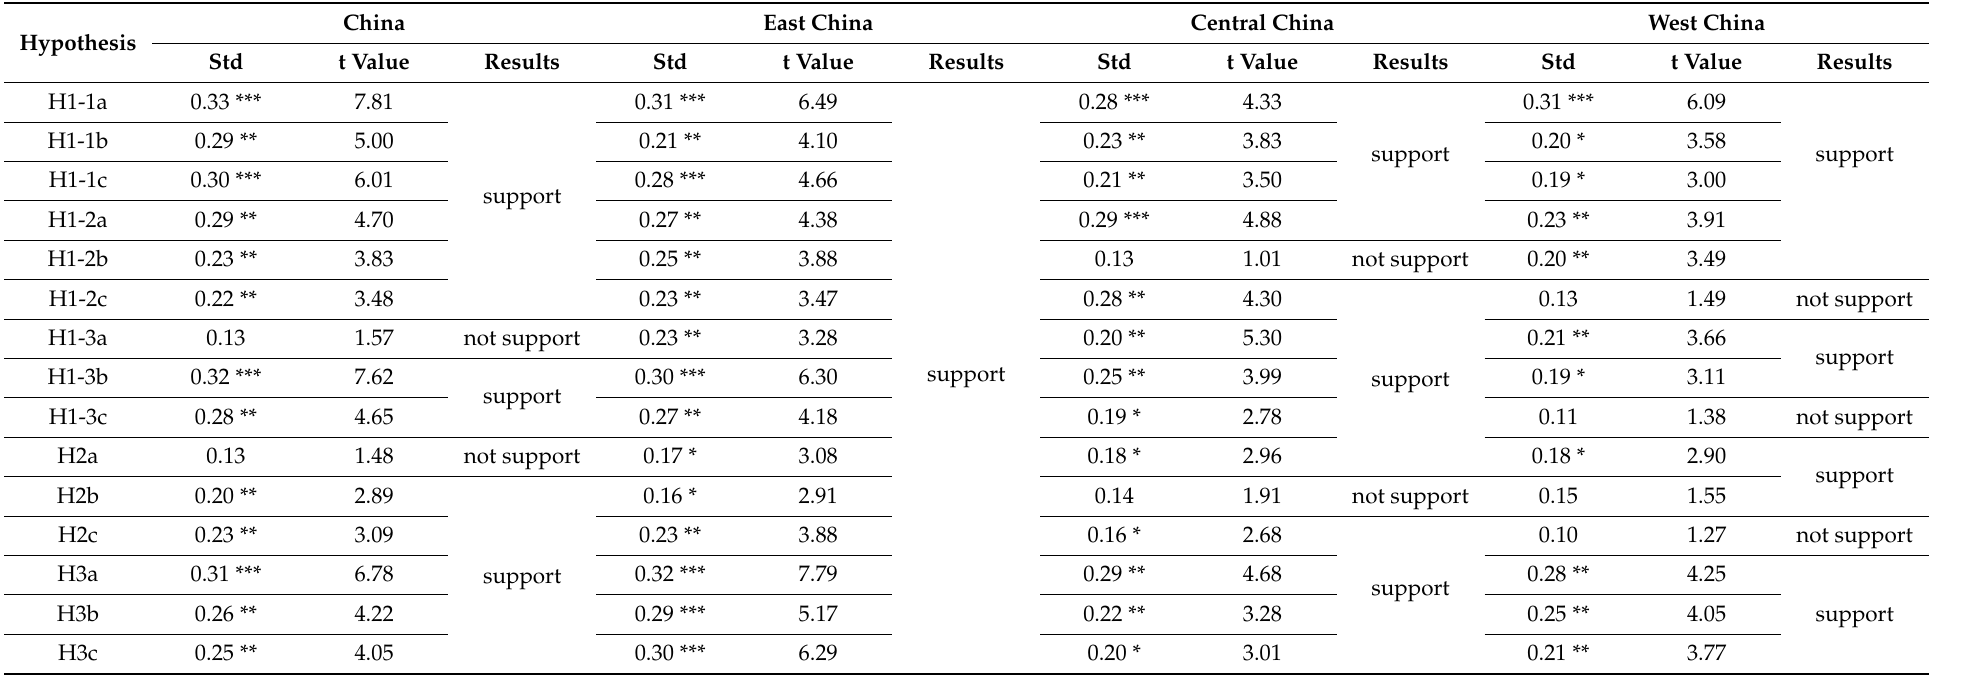
Table 4. Results of hypothesis